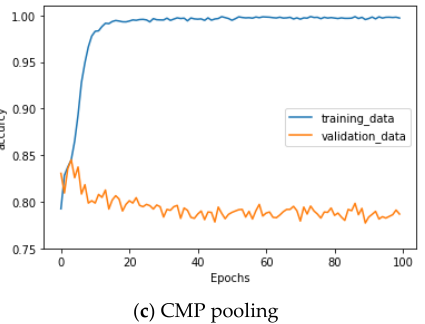
Figure 9. Pooling performance comparison using crawling data.